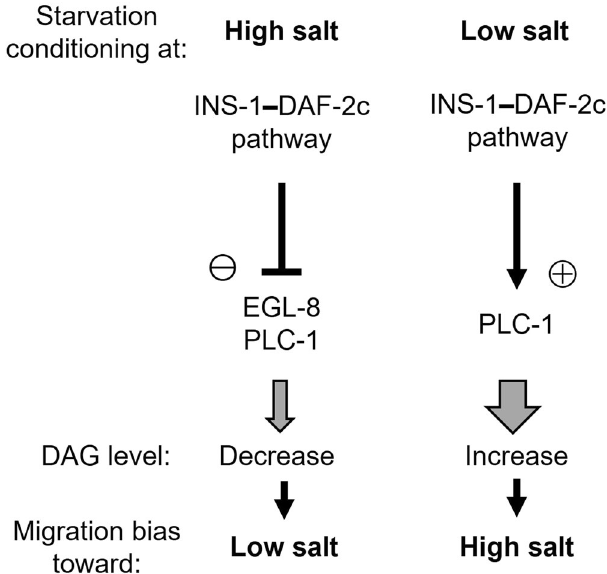
Fig. 7 The INS-1 – DAF-2c pathway promotes learned taste avoidance via distinct PLC isozymes. Worms migrate toward both higher and lower salt concentrations to effectively avoid the salt concentrations encountered under starvation conditions. We propose a model in which the INS-1 – DAF- 2c pathway exerts distinct effects on the PLC isozymes EGL-8 (PLC β ) and PLC-1 (PLC ε ) after starvation conditioning. We postulate that the INS- 1 – DAF-2c pathway suppresses EGL-8 and PLC-1 activities and elevate PLC-1 activity, which decreases and increases DAG levels, and thereby promotes both lower and higher salt migrations,